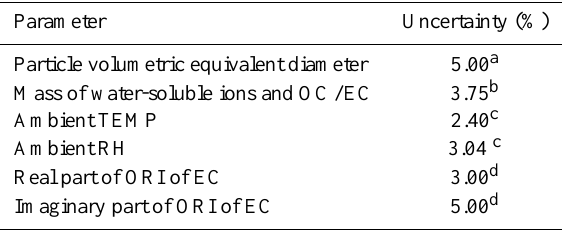
Table 7. The uncertainties attributed to input parameters of f sp (RH) calculation.